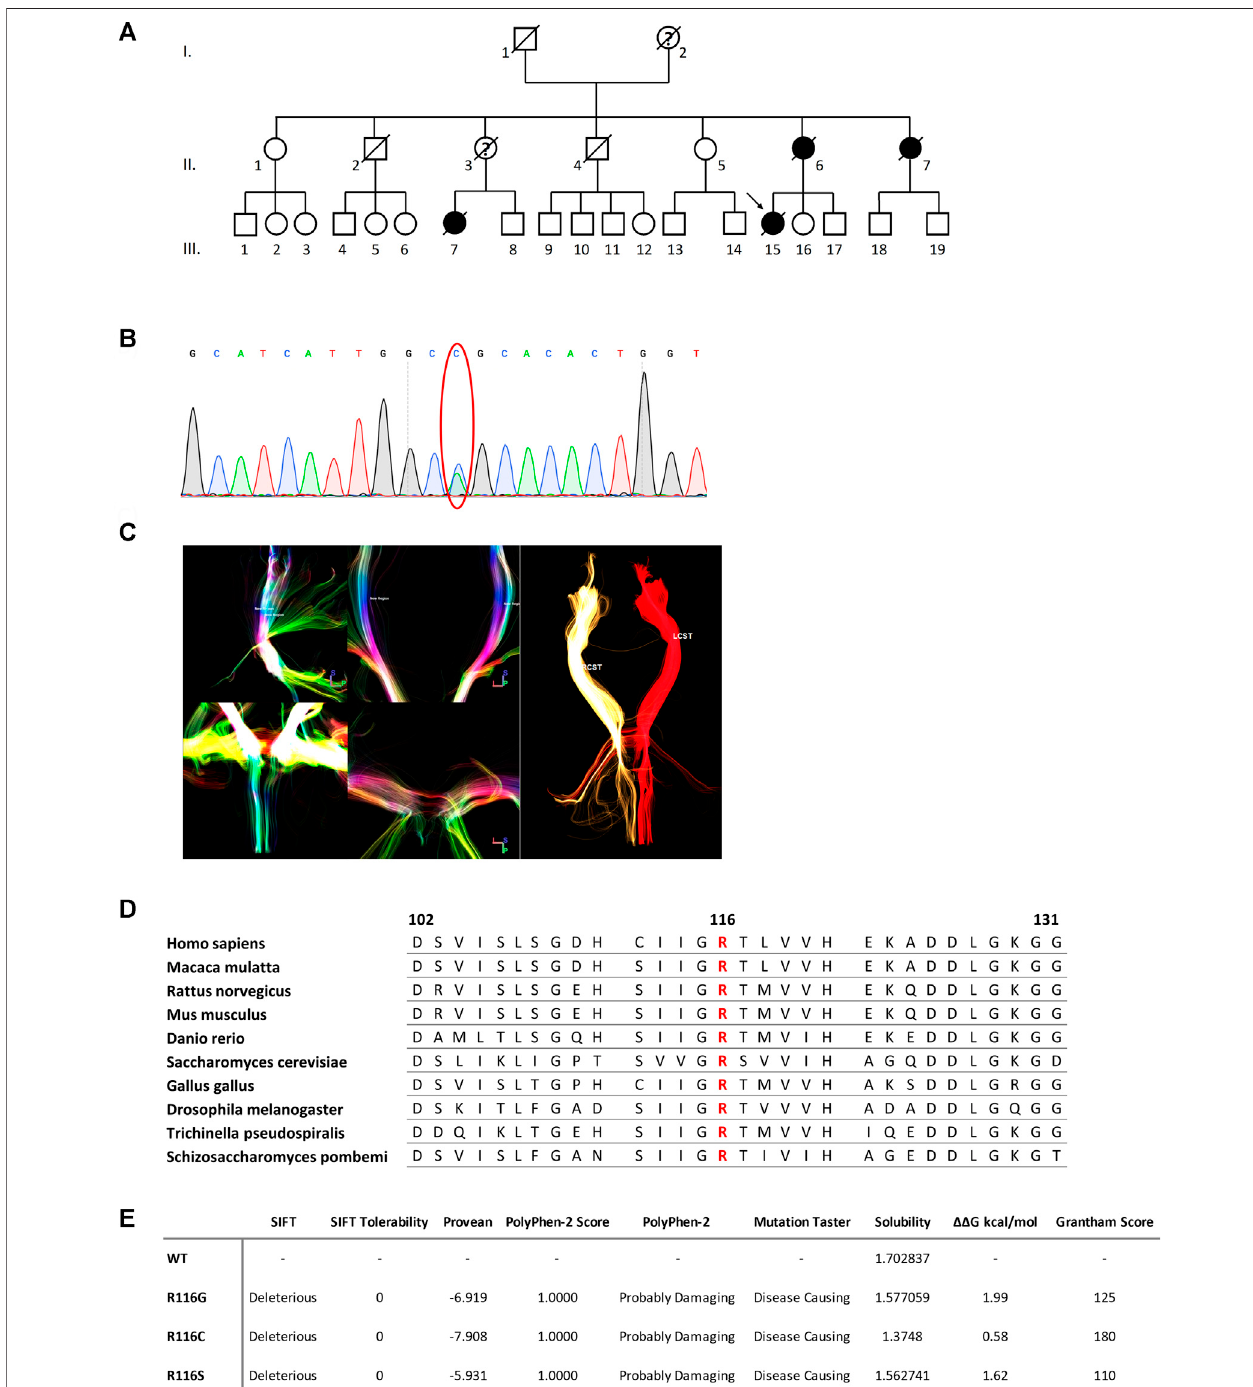
FIGURE 1 | (A) Pedigree of the family. Square (cid:1) male; circle (cid:1) female; diagonal black line (cid:1) deceased individual; black fi lled symbol (cid:1) clinically proven affected individual; empty symbol (cid:1) clinically healthy relative; question mark (cid:1) suspected; arrow (cid:1) proband. (B) DTI reconstruction of the bilateral cortical spinal tracts of the proband. RCST, right cortical spinal tract. LCST, left cortical spinal tract. (C) Con fi rmation by Sanger sequencing showing point mutation (red oval). (D) Sequence alignmentanalysisofSOD1indifferentspecies.Aminoacidatposition116ishighlightedinred. (E) Functionalpredictionofmutationsat116thaminoacidinSOD1.